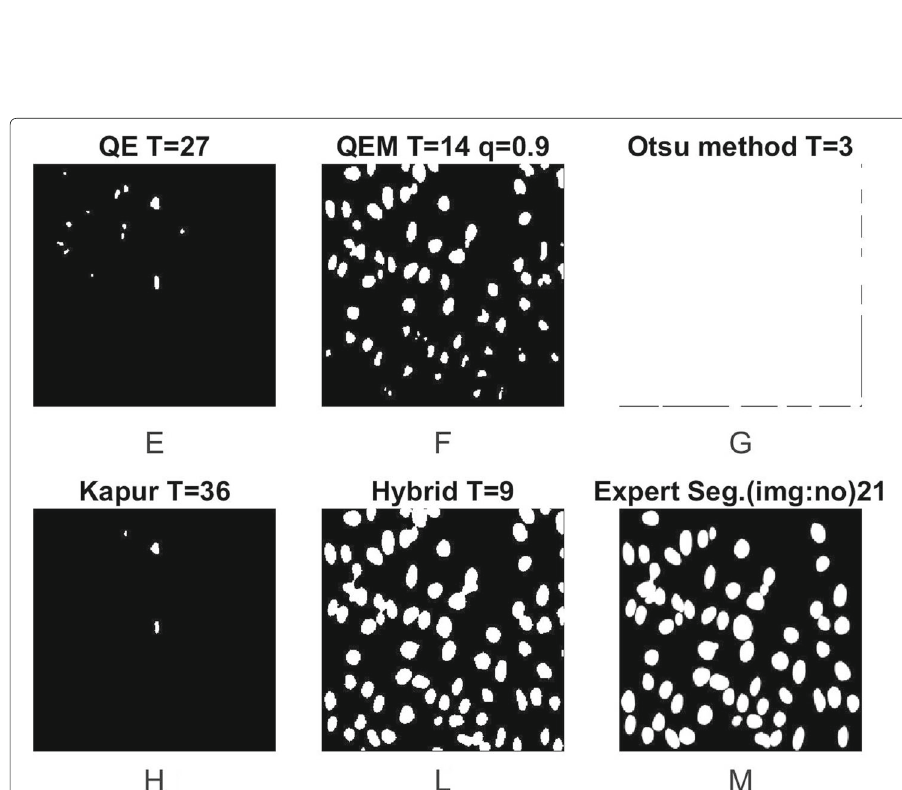
Fig. 10 F-measure= [0.0485 0.5941 0.3518 0.0194 0.8438] for quantum entropy, modified quantum entropy (proposed), Otsu, Kapur, and hybrid of the proposed with Otsu methods